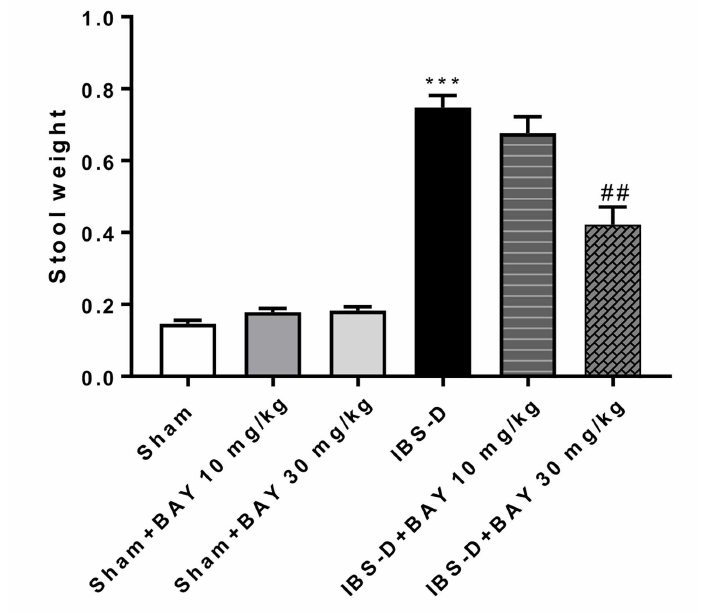
Figure 1. E ff ect of BAY 11-7082 treatment on restraint stress. The weight of stools was increased by water content in the Diarrhea-predominant irritable bowel syndrome (IBS-D) animals. However, the treatment with BAY 11-7082 30 mg / kg was able to reduce the weight of stools translated in a reduction of stress more than BAY 11-7082 10 mg / kg as shown in Figure 1. Data are representative of at least three independent experiments. *** p < 0.001 vs. Sham. ## p < 0.01 vs.